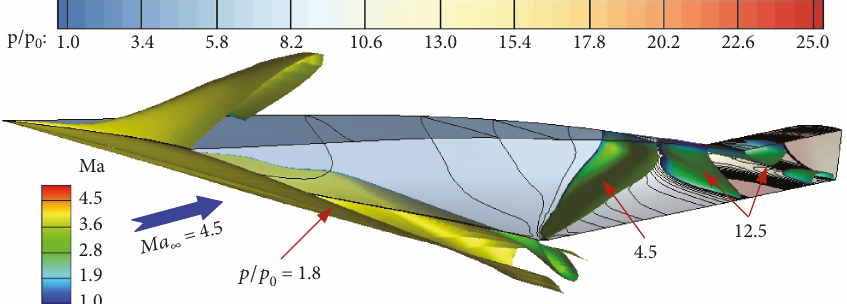
= 4 5 . The surface wall is contoured by the pressure ratio p/p ∞